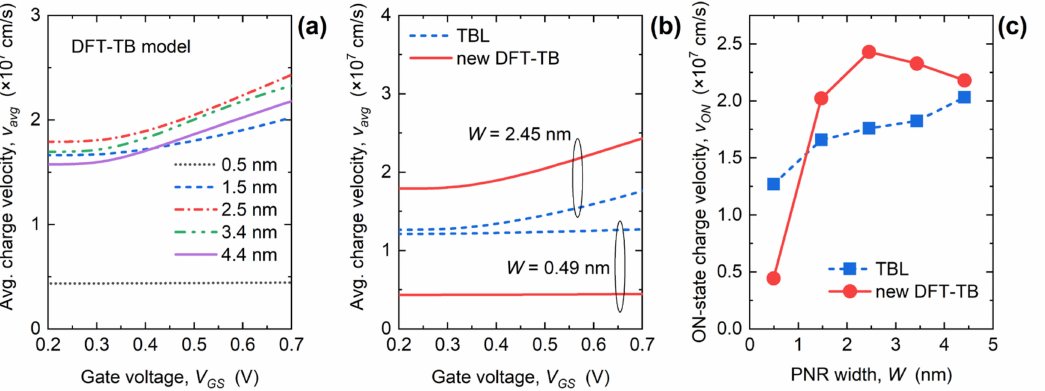
Figure 7. ( a ) Average charge velocity vs. V GS in PNR FETs for the DFT-TB model. Comparison of ( b ) v avg - V GS curves for 0.49 nm and 2.45 nm-wide PNR FETs, and ( c ) ON-state v avg - W characteristics obtained by the DFT-TB and TBL